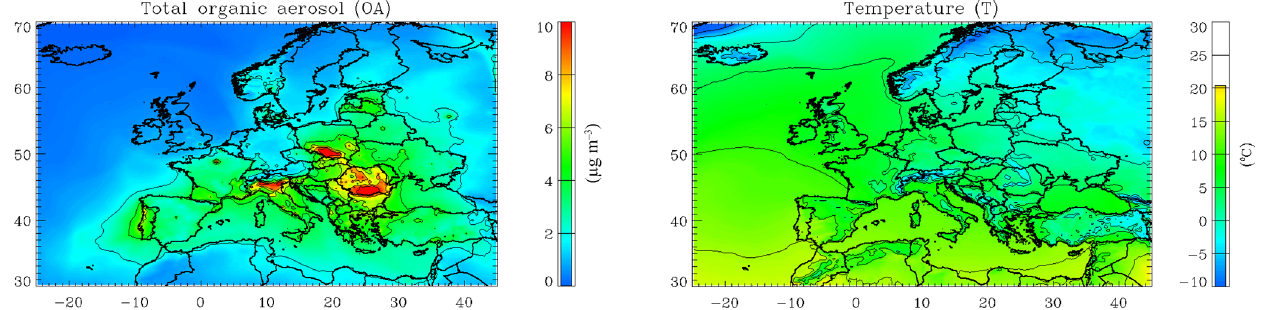
Figure 1. Modelled average total organic aerosol (OA) concentrations (VBS_BC_NEW) and surface temperature ( T ) for the period between 25 February and 26 March